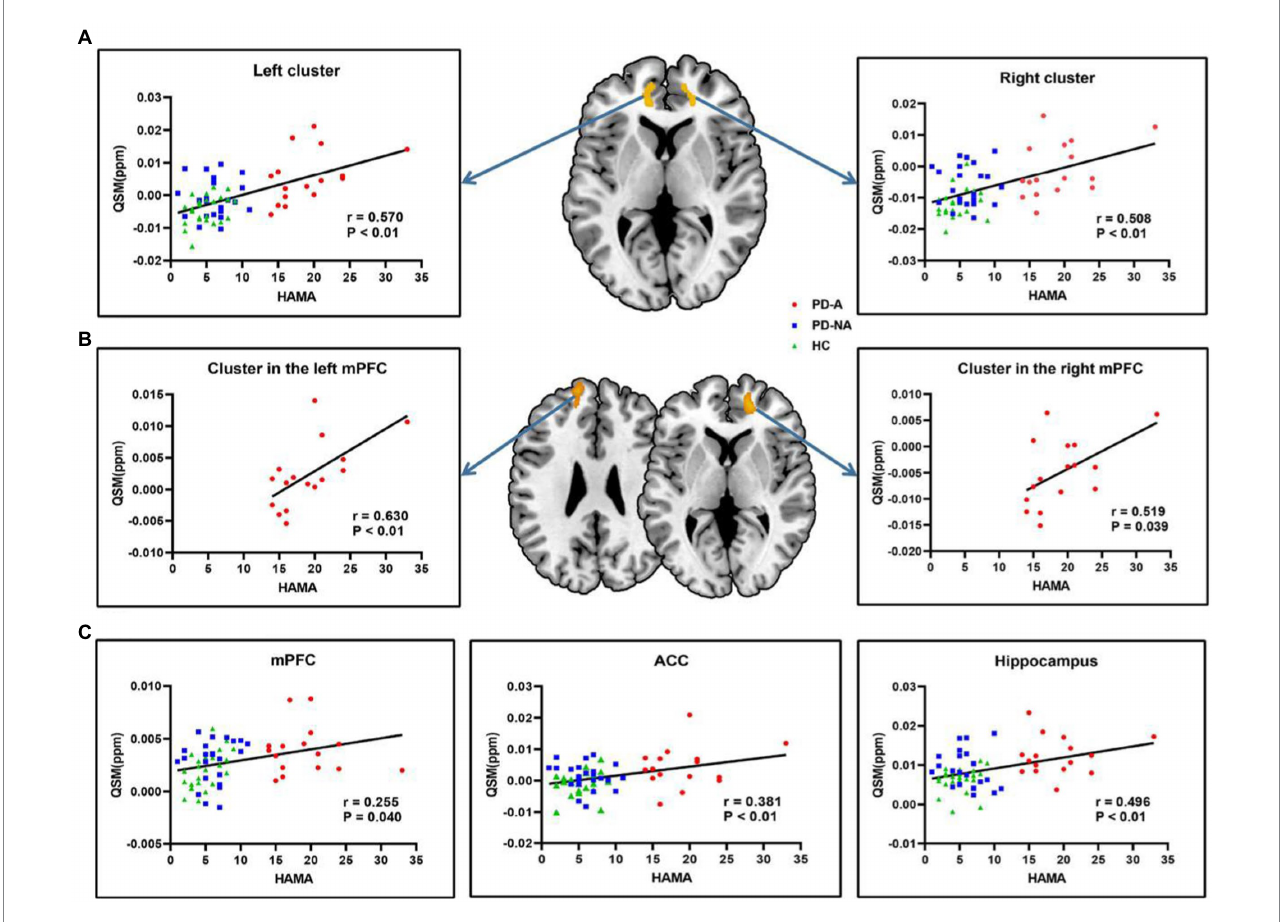
FIGURE 4 Correlation analysis in all subjects and in the single PD-A group. (A) The clusters with warm color represent significantly correlations between voxel-wise QSM values and HAMA scores in all subjects. (B) The clusters with warm color represent significantly correlations between voxel-wise QSM values and HAMA scores in the single PD-A group. (C) Significantly correlations between regional QSM values and HAMA scores in all subjects. QSM, Quantitative Susceptibility Mapping, HAMA, the Hamilton Anxiety Rating Scale, mPFC, medial prefrontal cortex; ACC, anterior cingulate